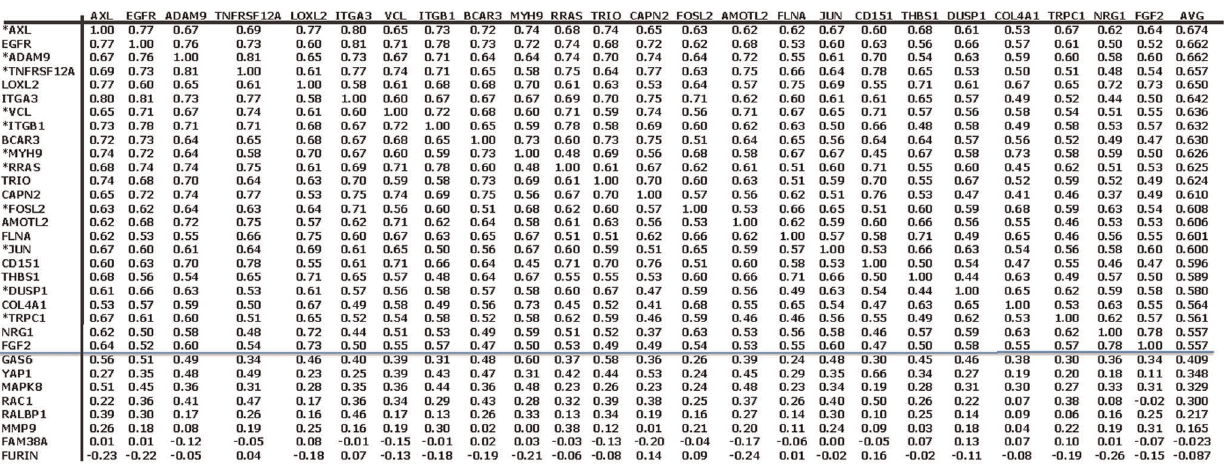
Figure 3. Expression profile cross-correlations of the 32 genes that participate in the interaction networks shown as molecular interaction maps in Figures 11 and 12. The right-most column lists the averages for each row. Above the horizontal line are 24 genes (HCCS24) that had expression profile cross-correlation averages greater than 0.50; these 24 genes are shown in red in Figures 11 and 12. Genes marked with an asterisk (*) were also in the HCCS15 gene set (Figure 1). Below the lines are genes that, although they participate in the networks shown in Figures 11 and 12, had expression profile correlations too low to be included in HCCS66 or HCCS24; these genes are shown in black in Figures 11 and 12. (Individual expression profile correlations . 0.30 were considered significant.)